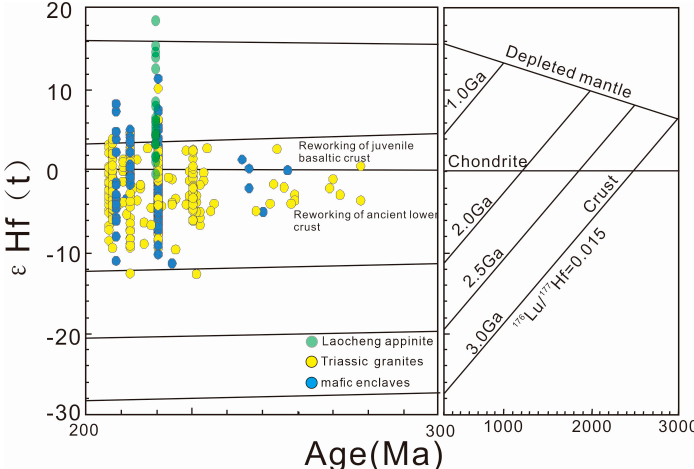
Figure 8. Age-corrected zircon ε Hf ( t ) vs. ages diagram for the zircons in Triassic granites, associated mafic enclaves and the Laocheng appinite in the Qinling orogenic belt. The Hf isotope ratios of the ancient crust basement are delimited by the 1.5 and 3.0 Ga juvenile crust evolution trends calculated assuming the 176 Lu/ 177 Hf of average continental crust